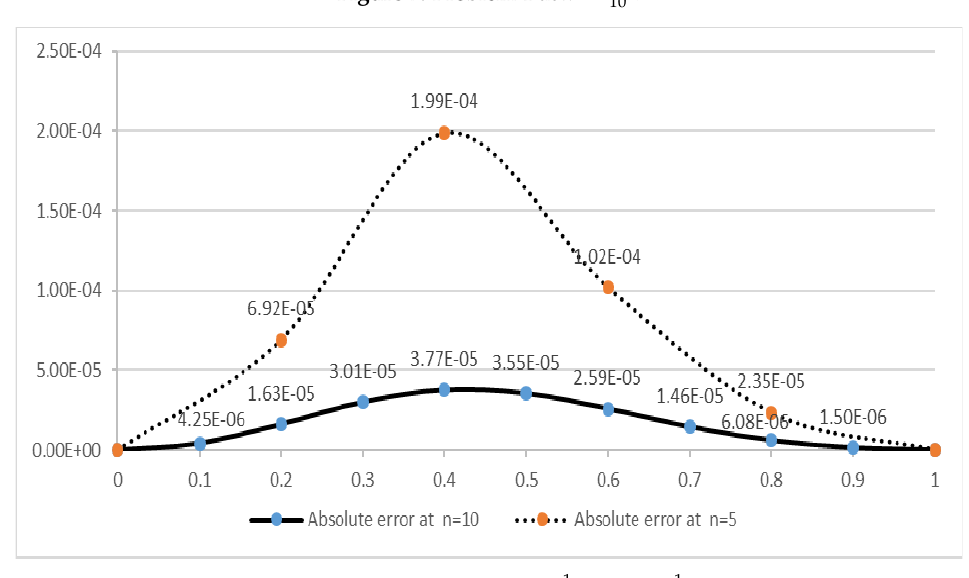
Figure 7. Problem 1 at h = 1